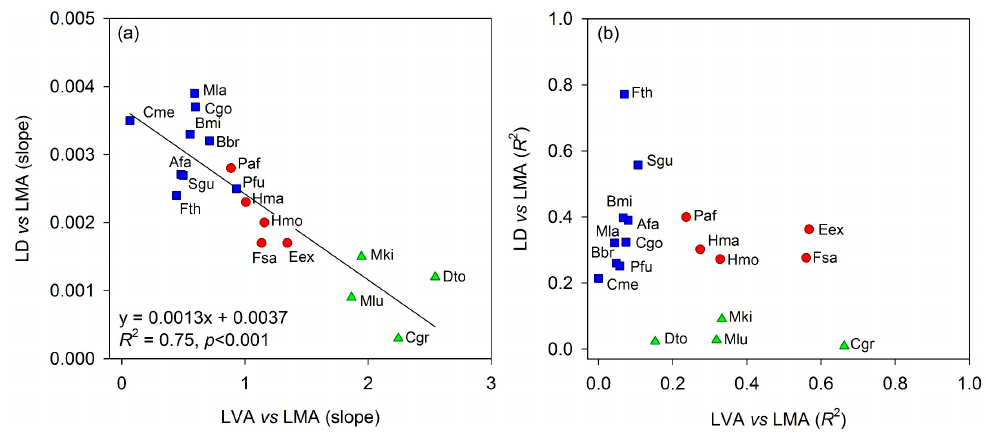
Figure 3. Slope ( a ) and R 2 ( b ) for leaf density (LD) versus leaf mass per unit area (LMA) in relation to slope and R 2 for leaf volume per unit area (LVA) versus LMA for 18 species (for species codes, see Table 2). Blue squares, LMA mainly influenced by LD; green triangles, LMA mainly influenced by LVA; red circles, LMA influenced by both LD and LVA. p -value refers to the regression